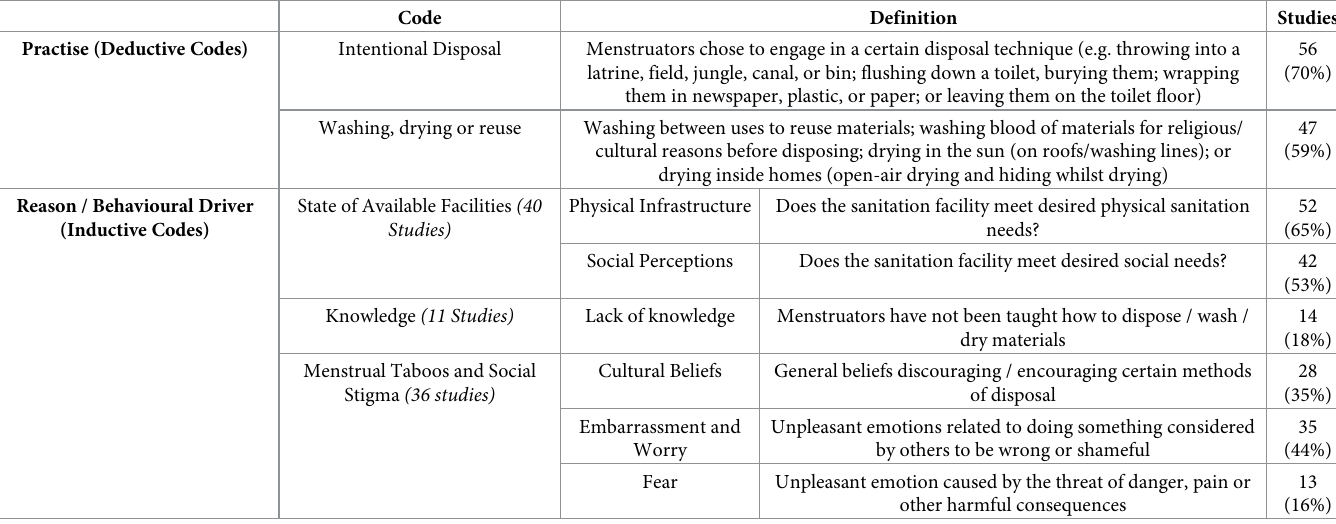
Table 3. Codebook definitions and coding